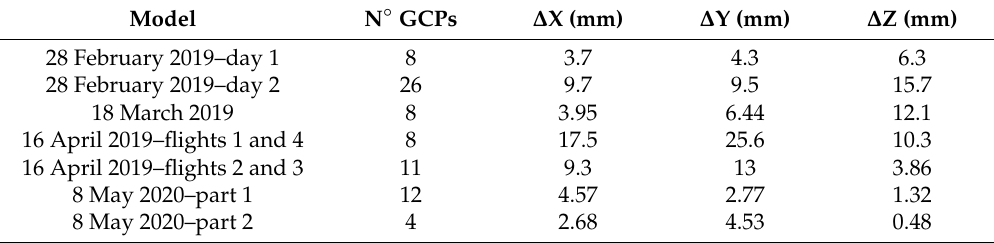
Table 2. GCPs counts and residual errors.